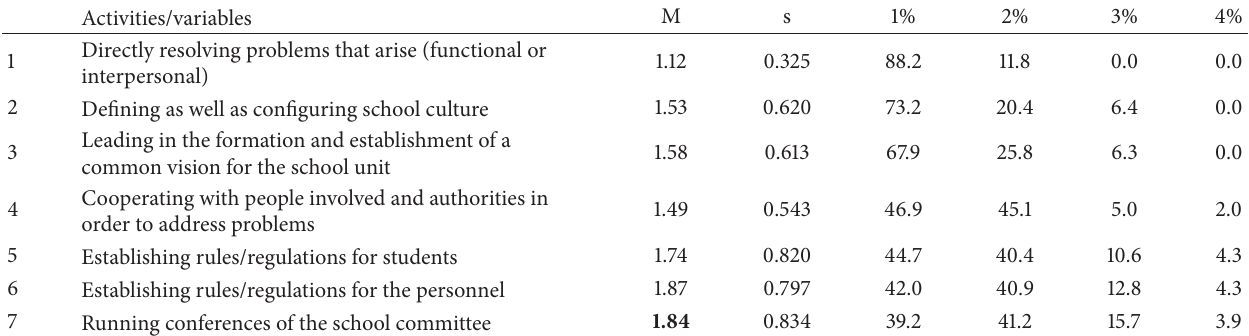
Table 1: The significance of activities related to the overall guidance and administration of the school unit.